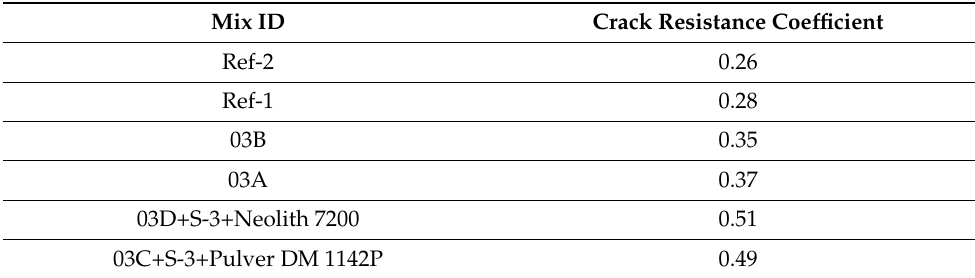
Table 11. Crack resistance coefficient of the lime